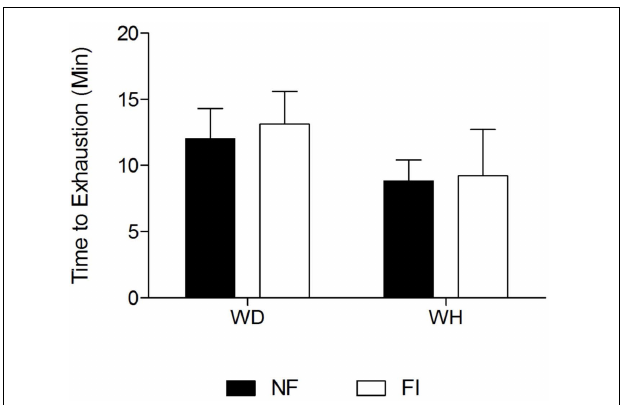
FIGURE 3 | Mean Time to Exhaustion (TTE) during the graded exercise phase in the fluid ingestion (FI) and non-fluid ingestion trial (NF) in a warm-dry (WD) and warm-humid (WH)